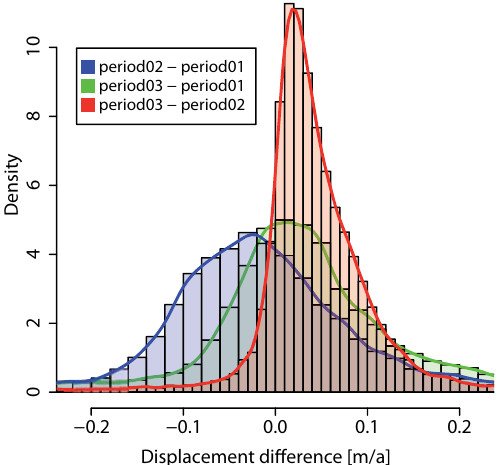
Figure 8. Frequency density distributions of annual displacement differences obtained by subtracting displacement vectors acquired within different observation